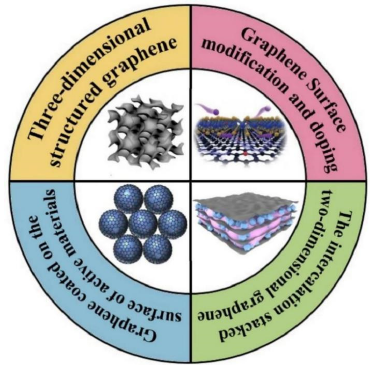
Figure 3. The main categories of graphene-based nanocomposites discussed in this study. Reproduced with permission [57–60]. Copyright 2018, Copyright Elsevier; 2021, Wiley-VCH;